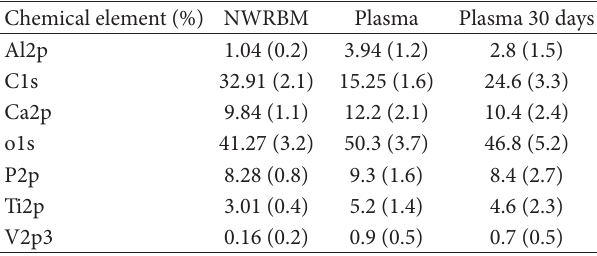
T 1: X-ray photoelectron spectroscopy (XPS) spectra for